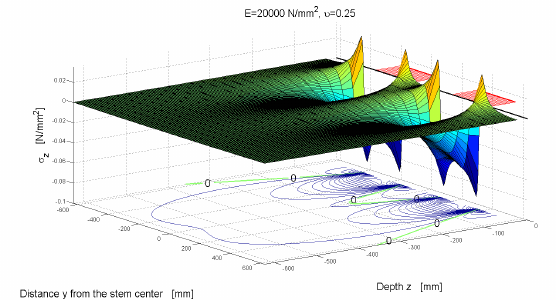
Figure 30: 3-D surface and stress contours of σ z on the A-A vertical cross-section of Figure 28 (second order solution).